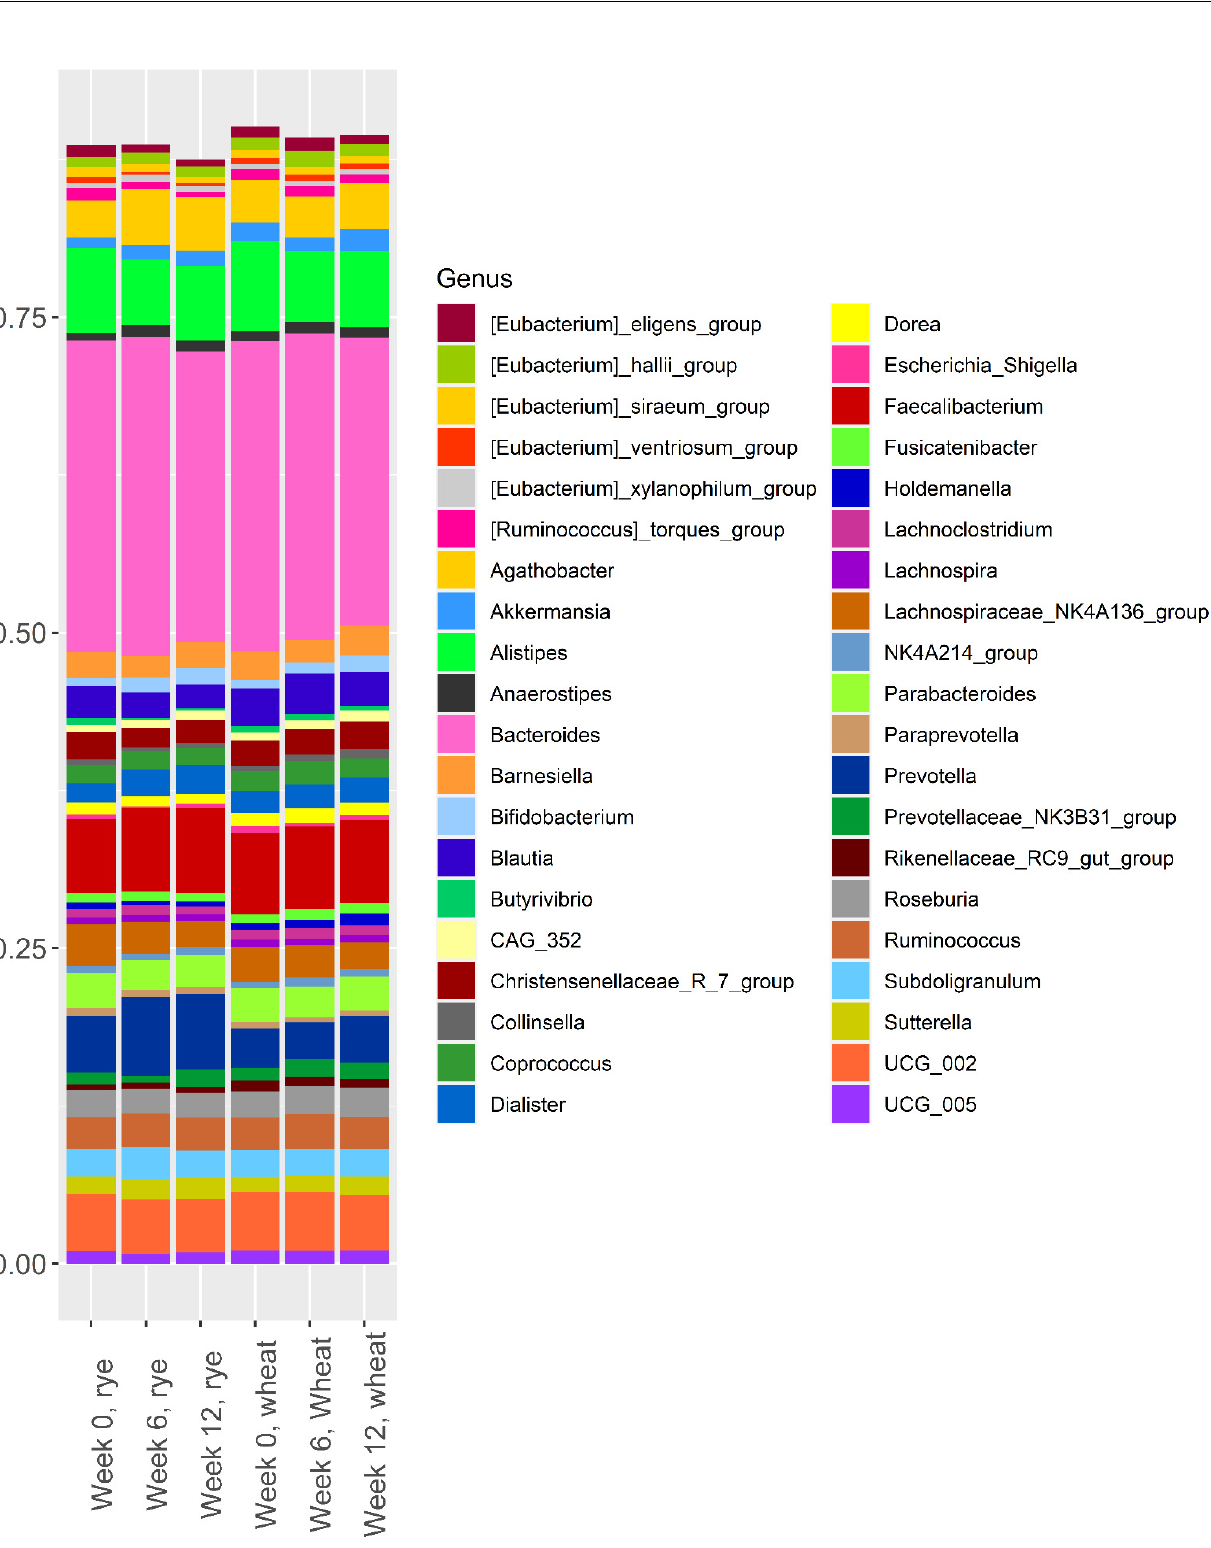
Figure 1. Relative abundance of the 40 most abundant bacteria at week 0, week 6, and week 12 in the rye group and the wheat group.